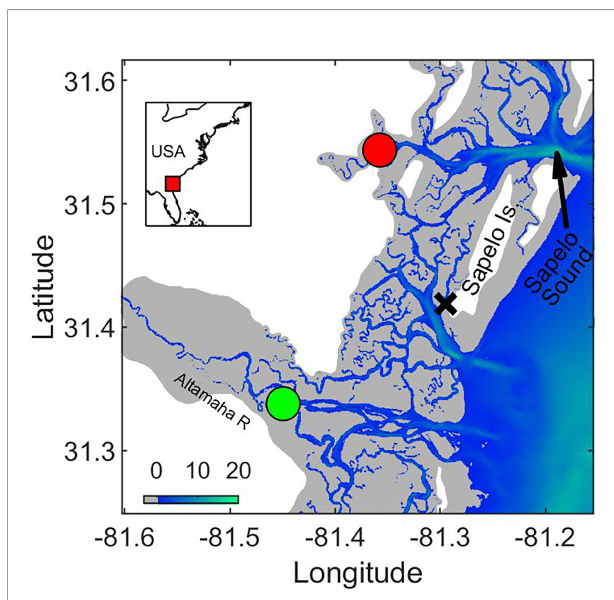
FIGURE 1 | Sampling location at the Altamaha River (green circle) and at the head of Sapelo Sound (red circle) off coastal Georgia (U.S.A.). Salt marshes and uplands are shown in gray and white, respectively. Colors indicate bottom topography in meters. Black cross shows the location of precipitation measurements at Marsh